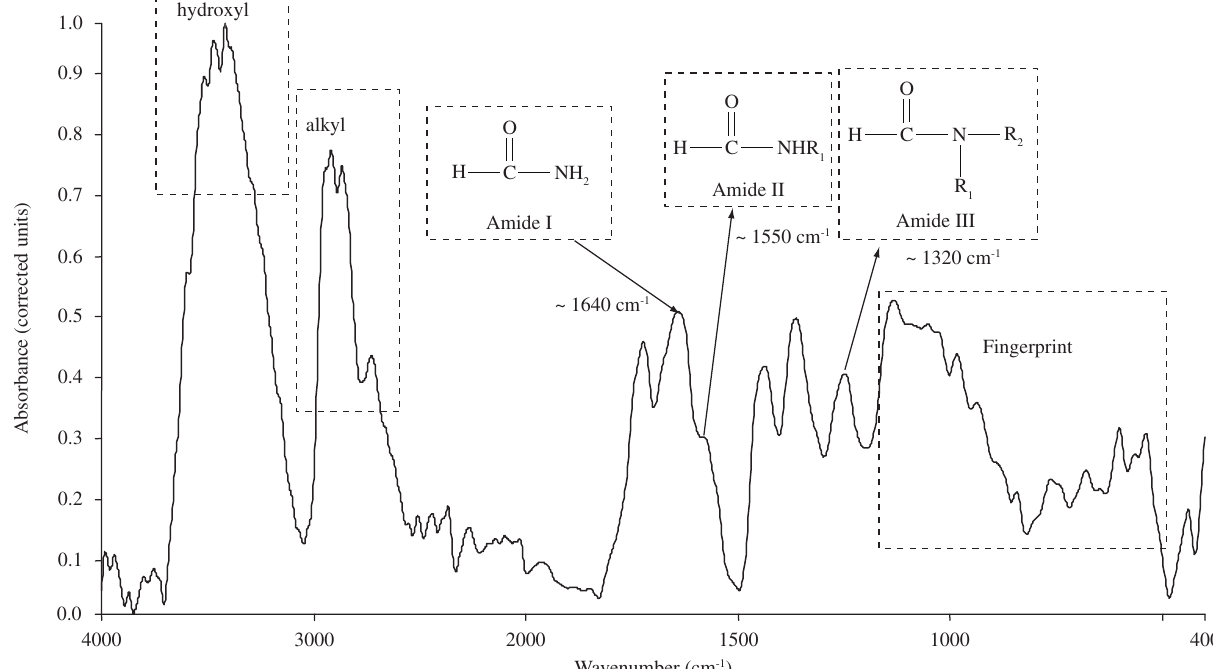
Figure 5. FTIR spectrum of pure MPB70 recombinant protein produced, purified and